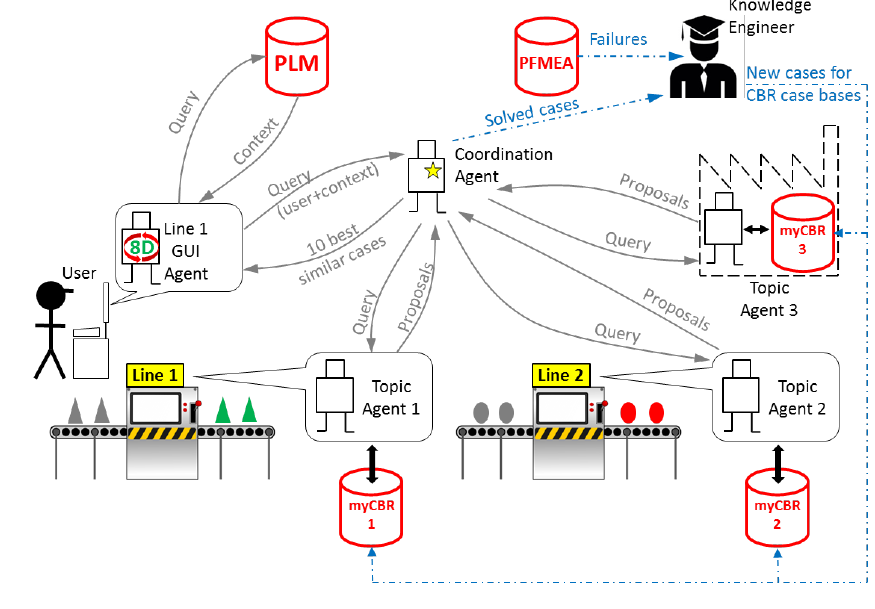
Figure 7. Communication model.